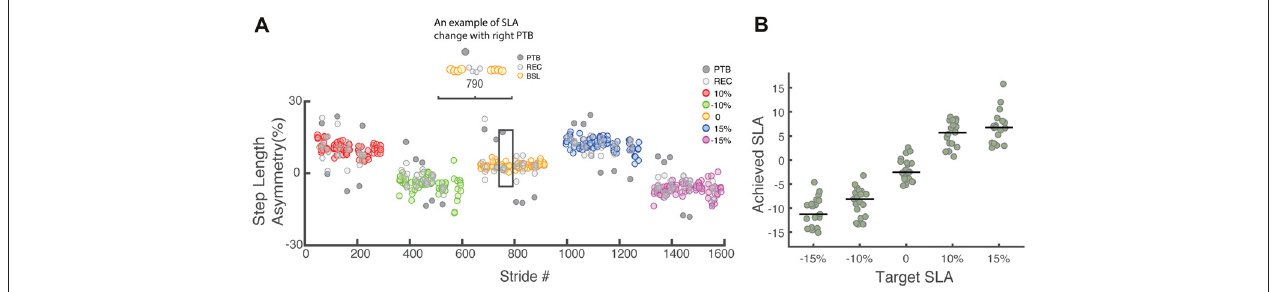
FIGURE 4 | (A) Raw step length asymmetry data for one representative participant. Each data point represents the step length asymmetry. The target asymmetries for this example followed the order of 10%, − 10%, 0, 15%, − 15%. Each target asymmetry is represented by a different color. BSL: baseline step; PTB: perturbation step; REC: recovery step. (B) Achieved step length asymmetry vs. target step length asymmetry for all participants ( N = 19). Achieved step length asymmetry is calculated as the average of all pre-perturbation strides and tends to undershoot the target at 15% and − 15%. The green dots represent individual data. Horizontal bars indicate the median across all